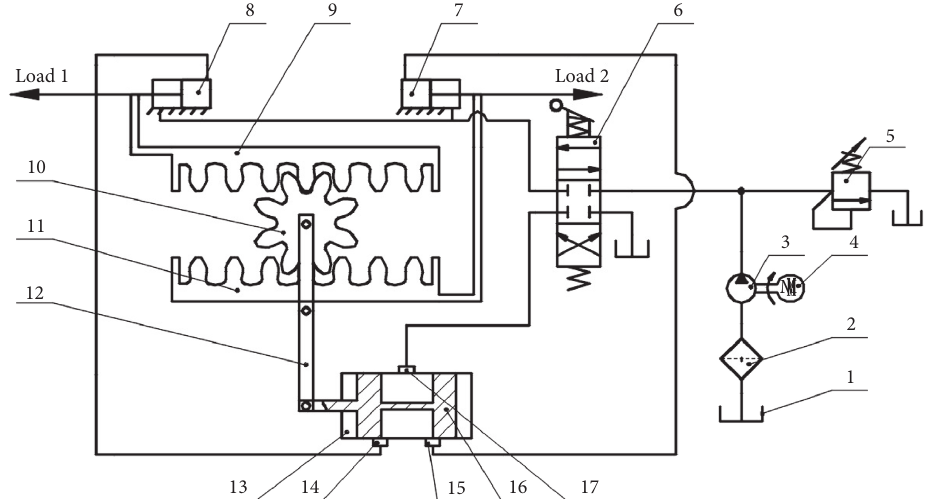
Figure 6: Schematic diagram of hydraulic control system: (1) oil source; (2) filter; (3) hydraulic pump; (4) motor; (5) overflow valve; (6) hand-directional valve; (7) hydraulic cylinder no. 2; (8) hydraulic cylinder no. 1; (9) rack no. 1; (10) displacement gear; (11) rack no. 2; (12) lever; (13) bidirectional shunt follow-up valve; (14) oil outlet no. 1; (15) oil outlet no. 2; (16) valve core; (17) oil